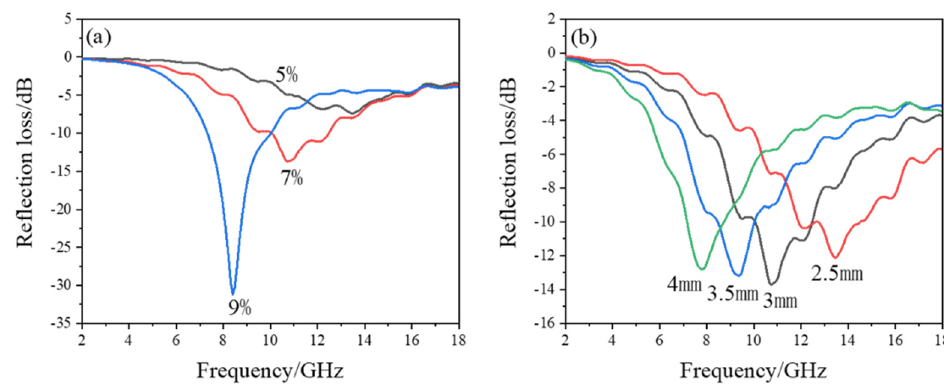
Figure 4. Reflection loss of PCNF composites: ( a ) different contents of PCNF at 3 mm thickness; ( b ) varied thicknesses at PCNF content of 7%.